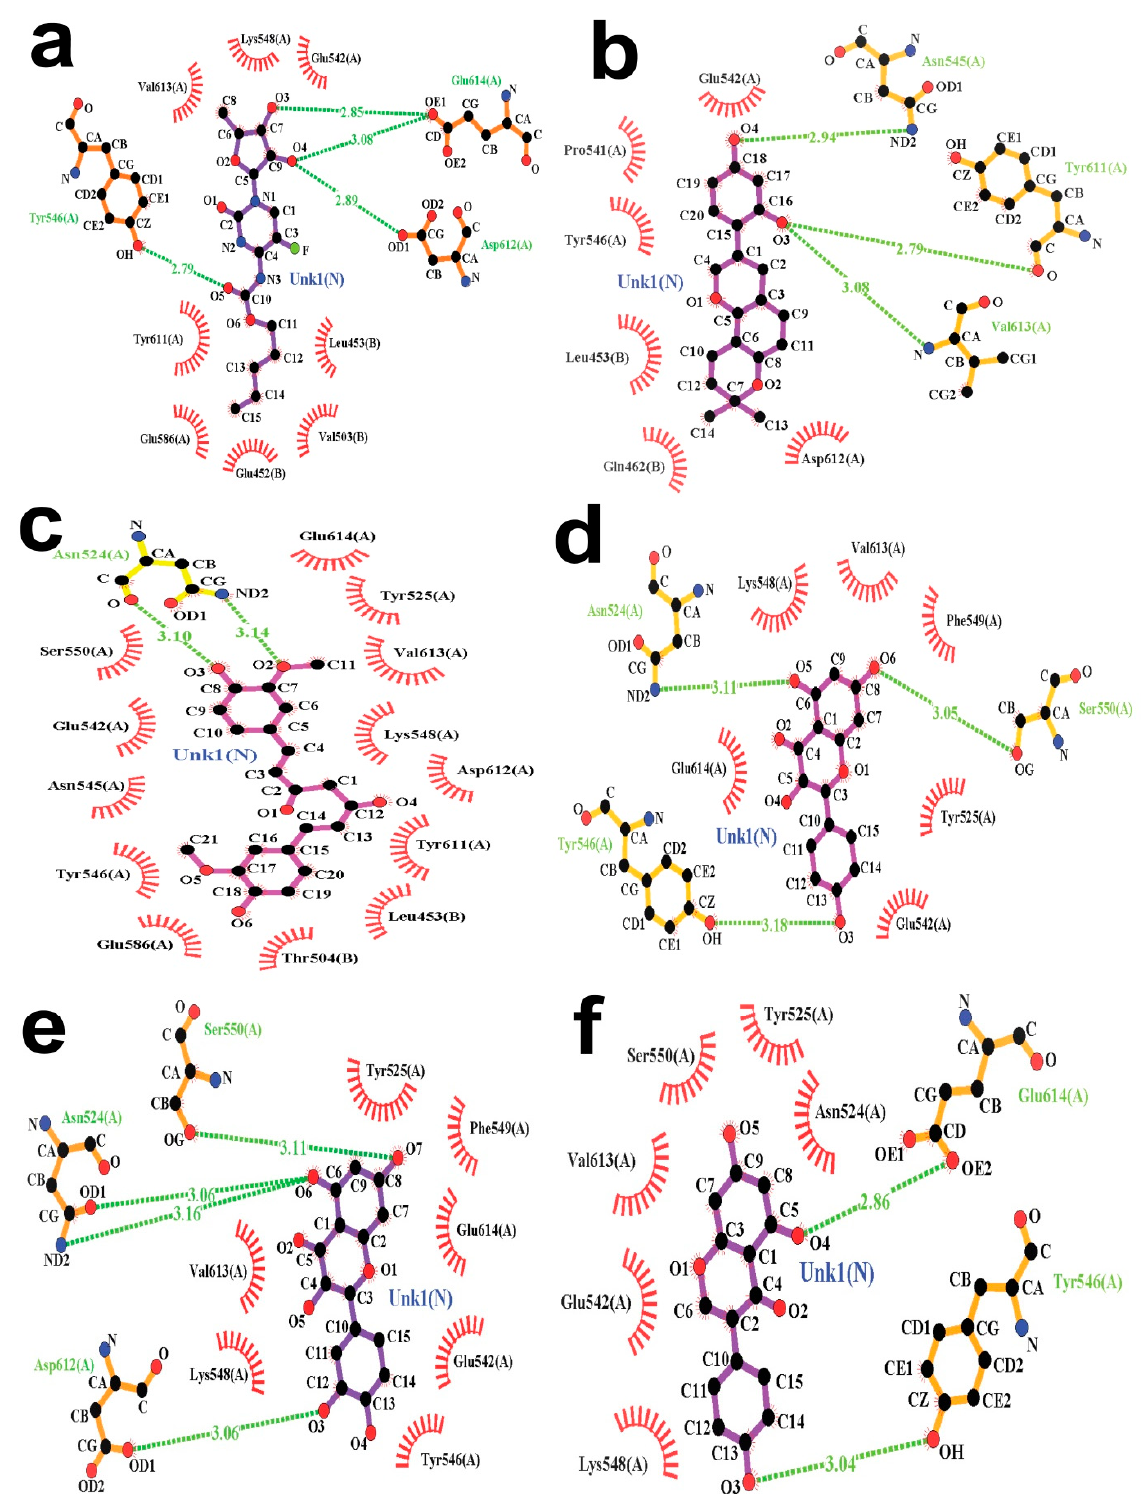
Figure 7. The docked conformation of the “SYK kinase-lead molecule complexes” represents the potential hydrogen and hydrophobic interactions, with hydrogen bonds shown as olive green dotted lines with a specific distance (Å) and hydrophobic interactions shown as red oval-shaped structures. The hydrophobic interactions are shown by thin red lines with ellipses in protein residues. The protein residues that are primarily similar in 3D positions are marked by red spiked arc ellipses. CAP (control)–SYK complex ( a ), Glabridin–SYK complex ( b ), Curcumin–SYK complex ( c ), Kaempferol–SYK complex ( d ), Quercetin–SYK complex ( e ), and Genistein–SYK complex ( f ).